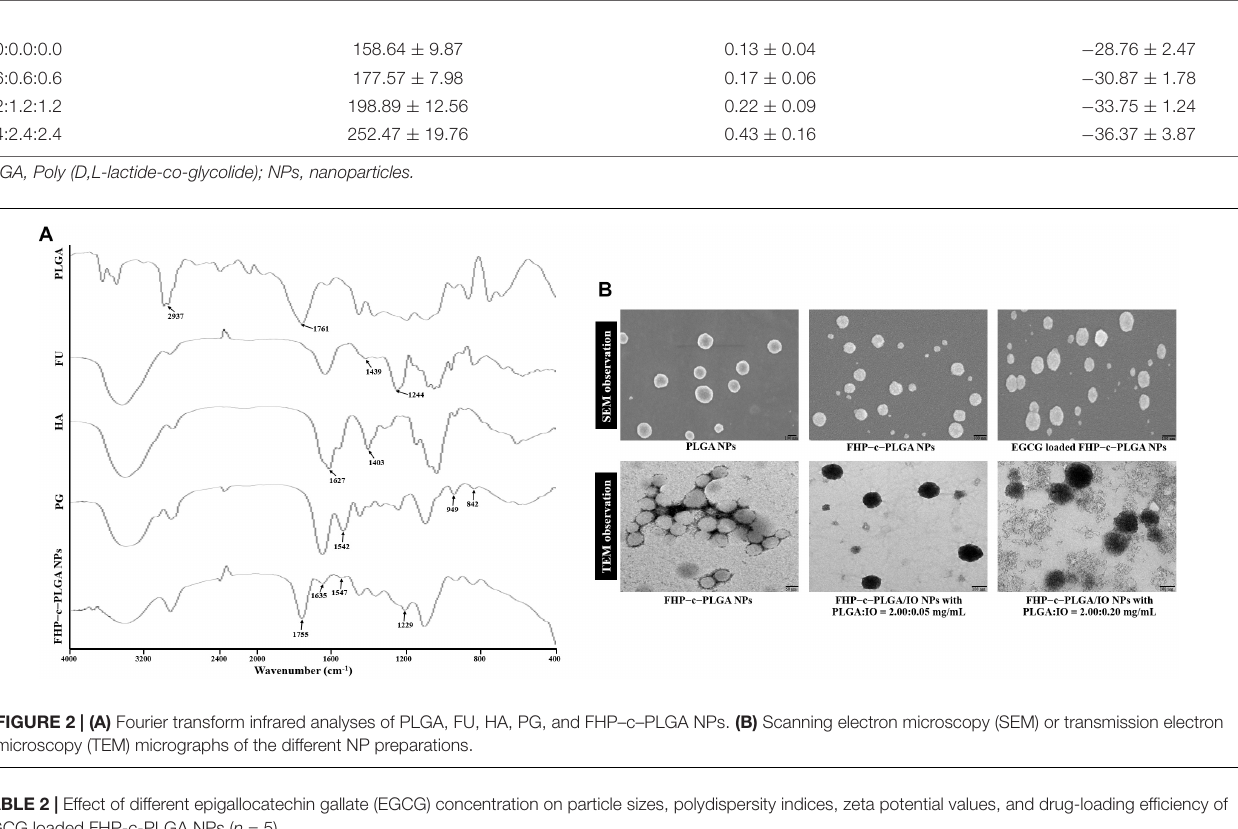
TABLE 1 | Effect of different FU/HA/PG concentrations on particle sizes, polydispersity indices, and zeta potential values of the FHP-c-PLGA NPs ( n = 5). FU:HA:PG (mg/mL)